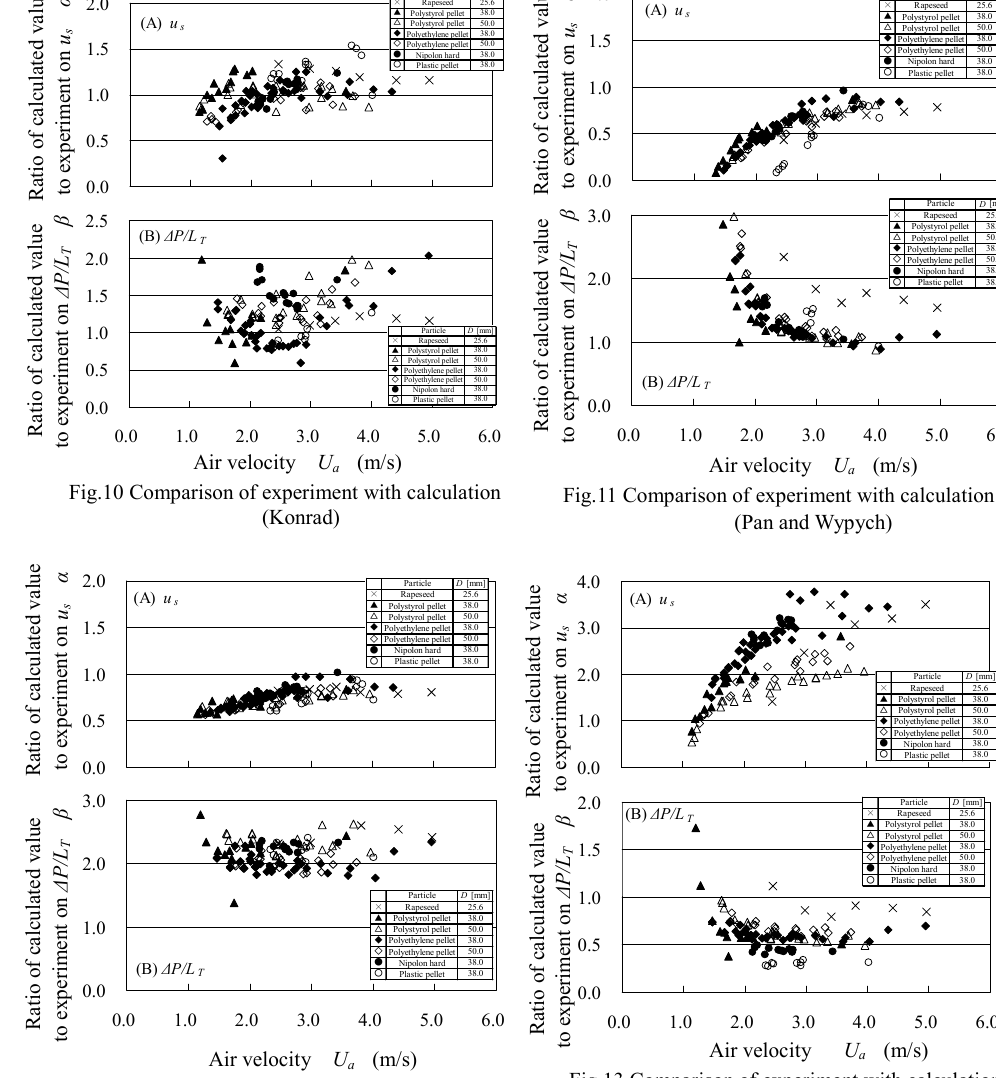
Fig.12 Comparison of experiment with calculation